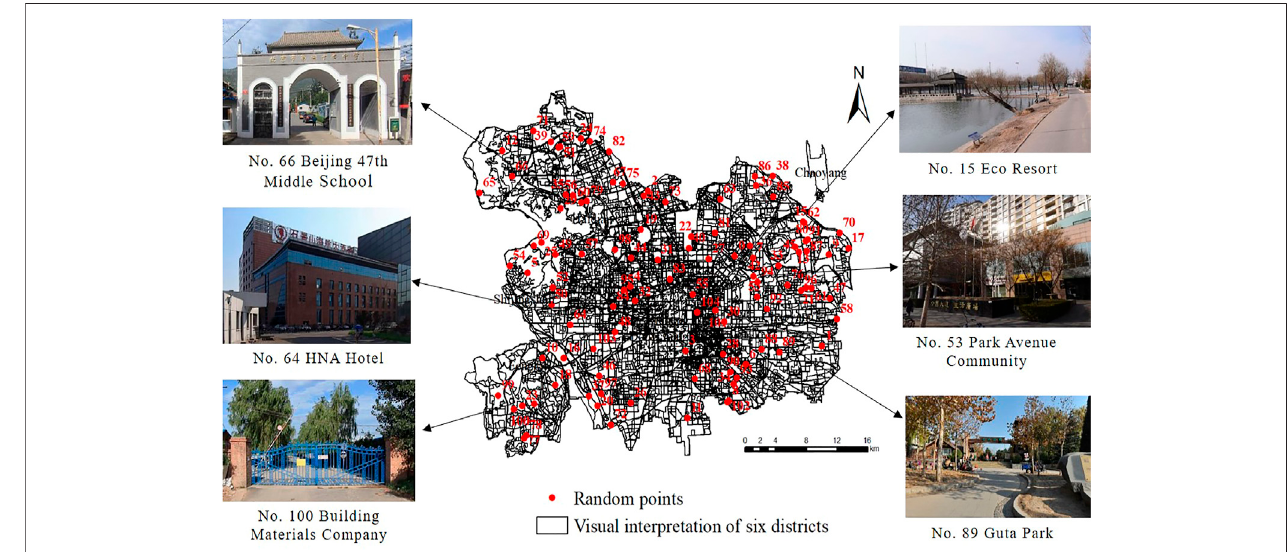
FIGURE 7 | Accuracy detection of interpretation results and presentation of some